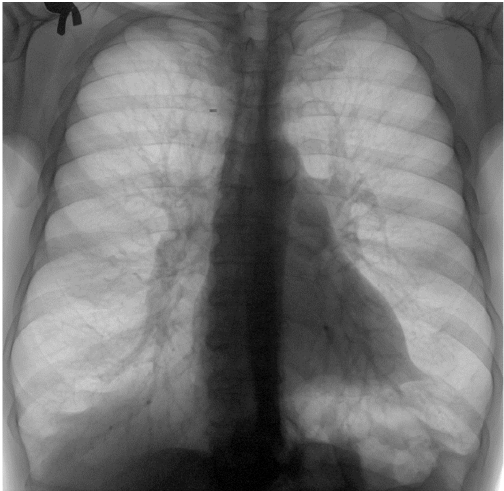
Figure 8. The image from Figure 7 in “Invert color” format.